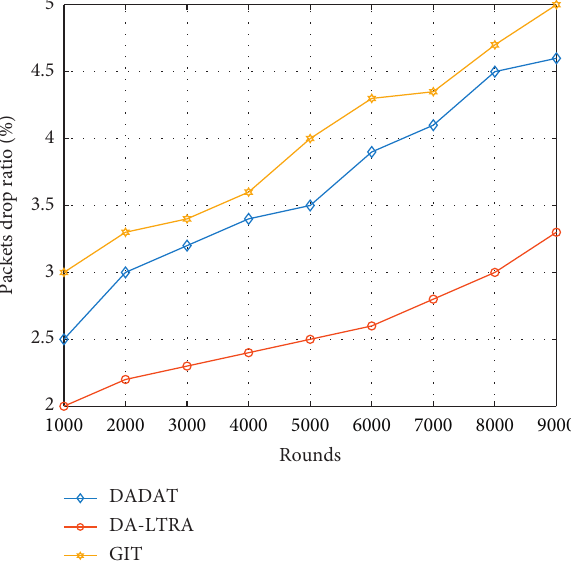
Figure 13: Overheads of energy under different rounds.